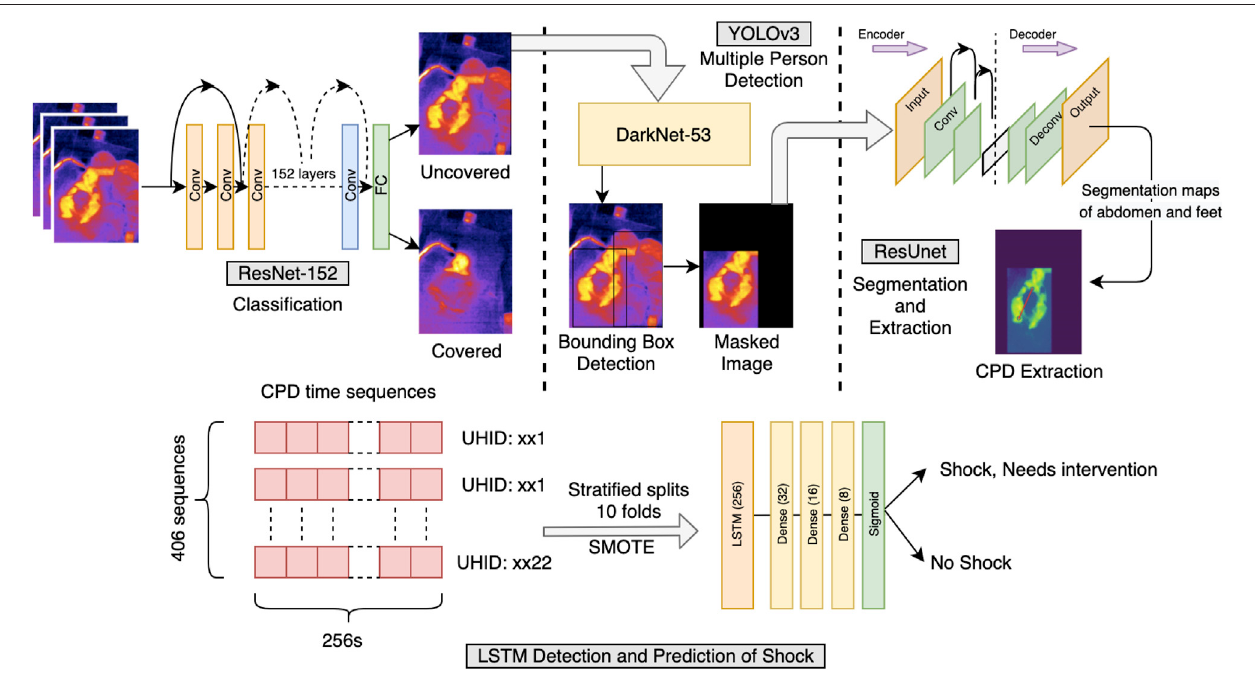
FIGURE 2 | Shock prediction pipeline. Illustration of the pipeline followed for the detection and prediction of shock and no-shock. Each frame of the video was examined for uncovered/covered. The uncovered frames were then fi ltered off the presence of people other than the patient present in the frame. The frame was fi nally passed from the segmentation and CPD extraction model, further collecting the sequences used for LSTM time-series classi fi cation. The time sequences had CPD and heartrateasfeaturesandanappropriatewindowlengthof256 swaschosen.Sincethedatawerehighlyimbalanced,theSMOTEupsamplingmethodwasusedin training the LSTM model. The detection and prediction of shock were carried out at 0 h and for the next 6 h, respectively.